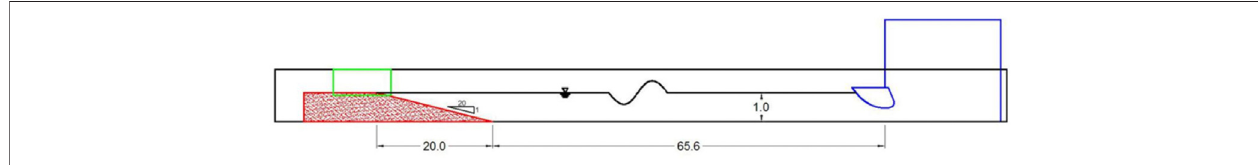
FIGURE 5 | Schematic of the second generation TS for URBANWAVES phase 1 testing, bathymetry in red on the left with the fl ume window in green and the second generation TS in blue on the right.